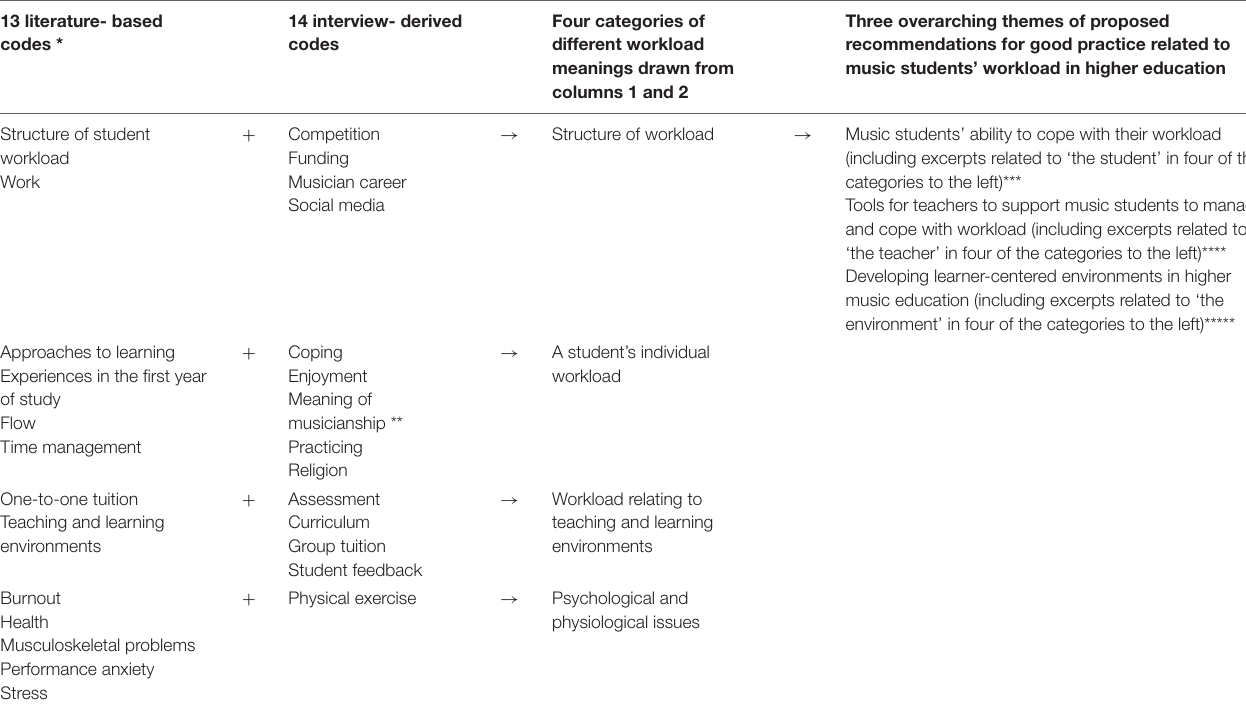
TABLE 2 | Thematic coding framework.